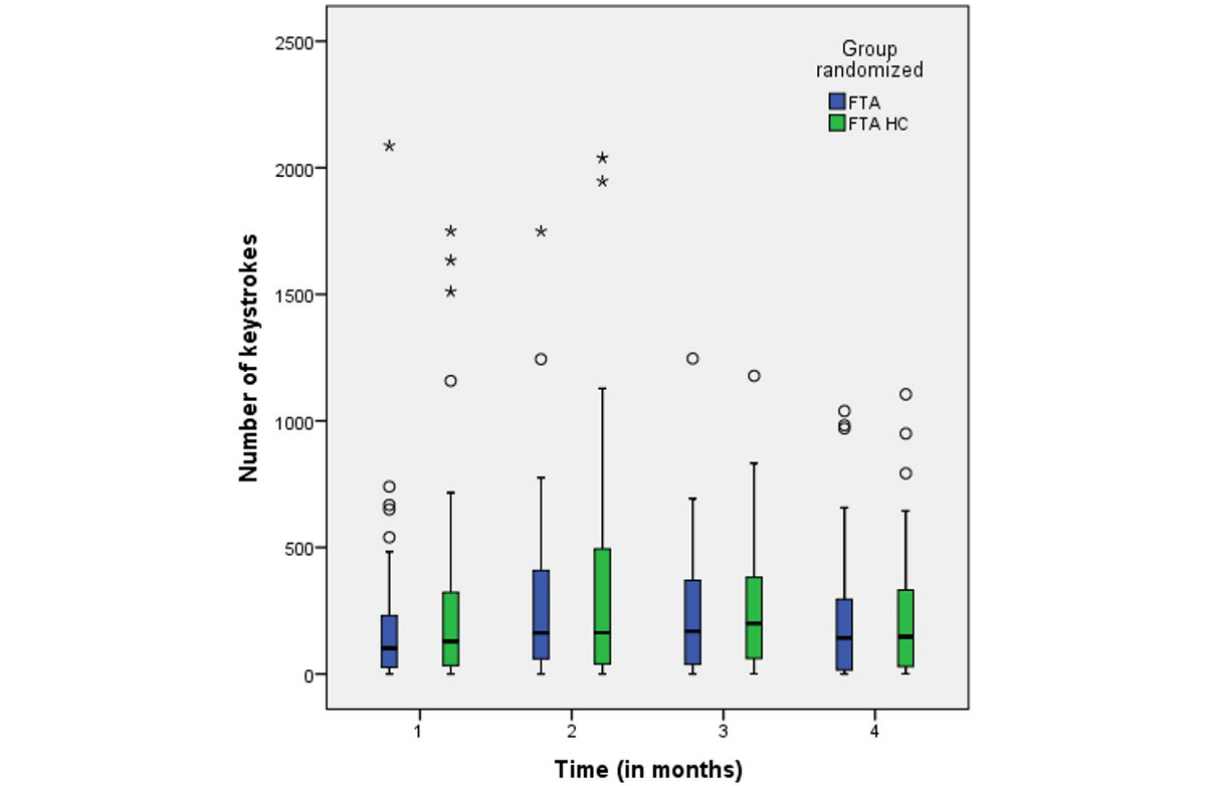
Figure 3. Number of keystrokes during the first 4 months for the 2 intervention groups: Few Touch Application (FTA) and FTA with health counseling (HC). Time 1 (baseline): n=90; time 2: n=83; time 3: n=80; and time 4: